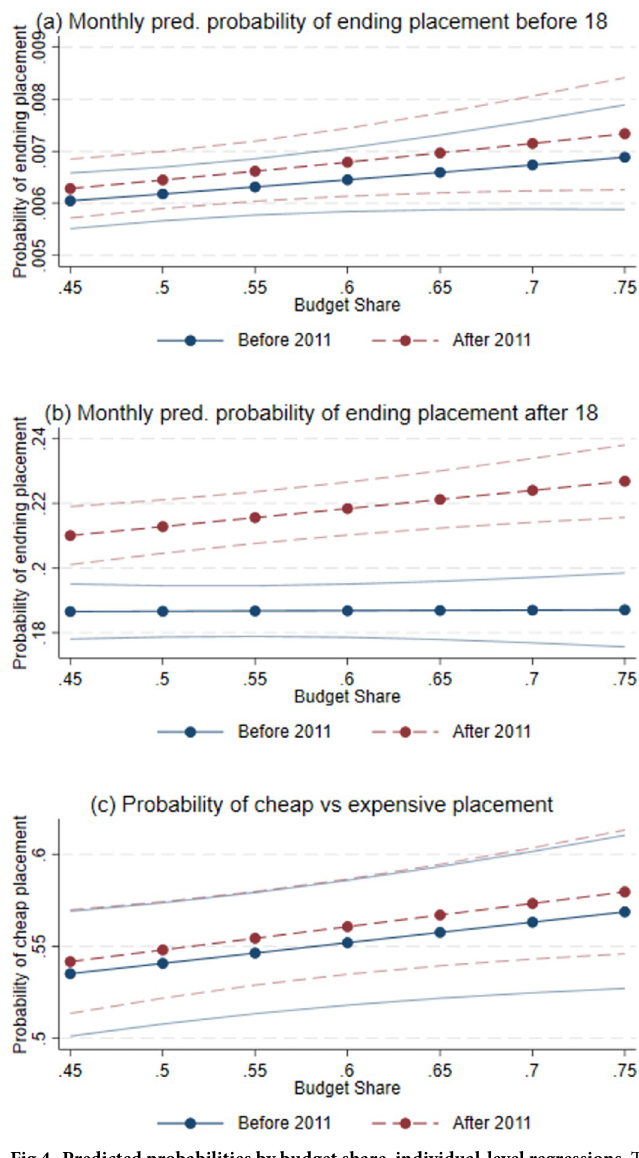
Fig 4. Predicted probabilities by budget share, individual-level regressions. The Figures show the marginal effects of the budget share on the individual outcomes. Panel (a) shows the predicted monthly probability of ending a placement for children in care below 18. Panel (b) shows the predicted monthly probability of ending a placement for children above 18 in care. Panel (c) shows the predicted probability for a cheap out-of-home placement (e.g. foster families) instead of an expensive (institutional care). The predictions are based on estimates of the logit specification in Eq (3). The predicted probabilities are calculated from July. The logit model is estimated using individual-level data from the period 2007-2016. The dashed lines indicate the 95 percent confidence